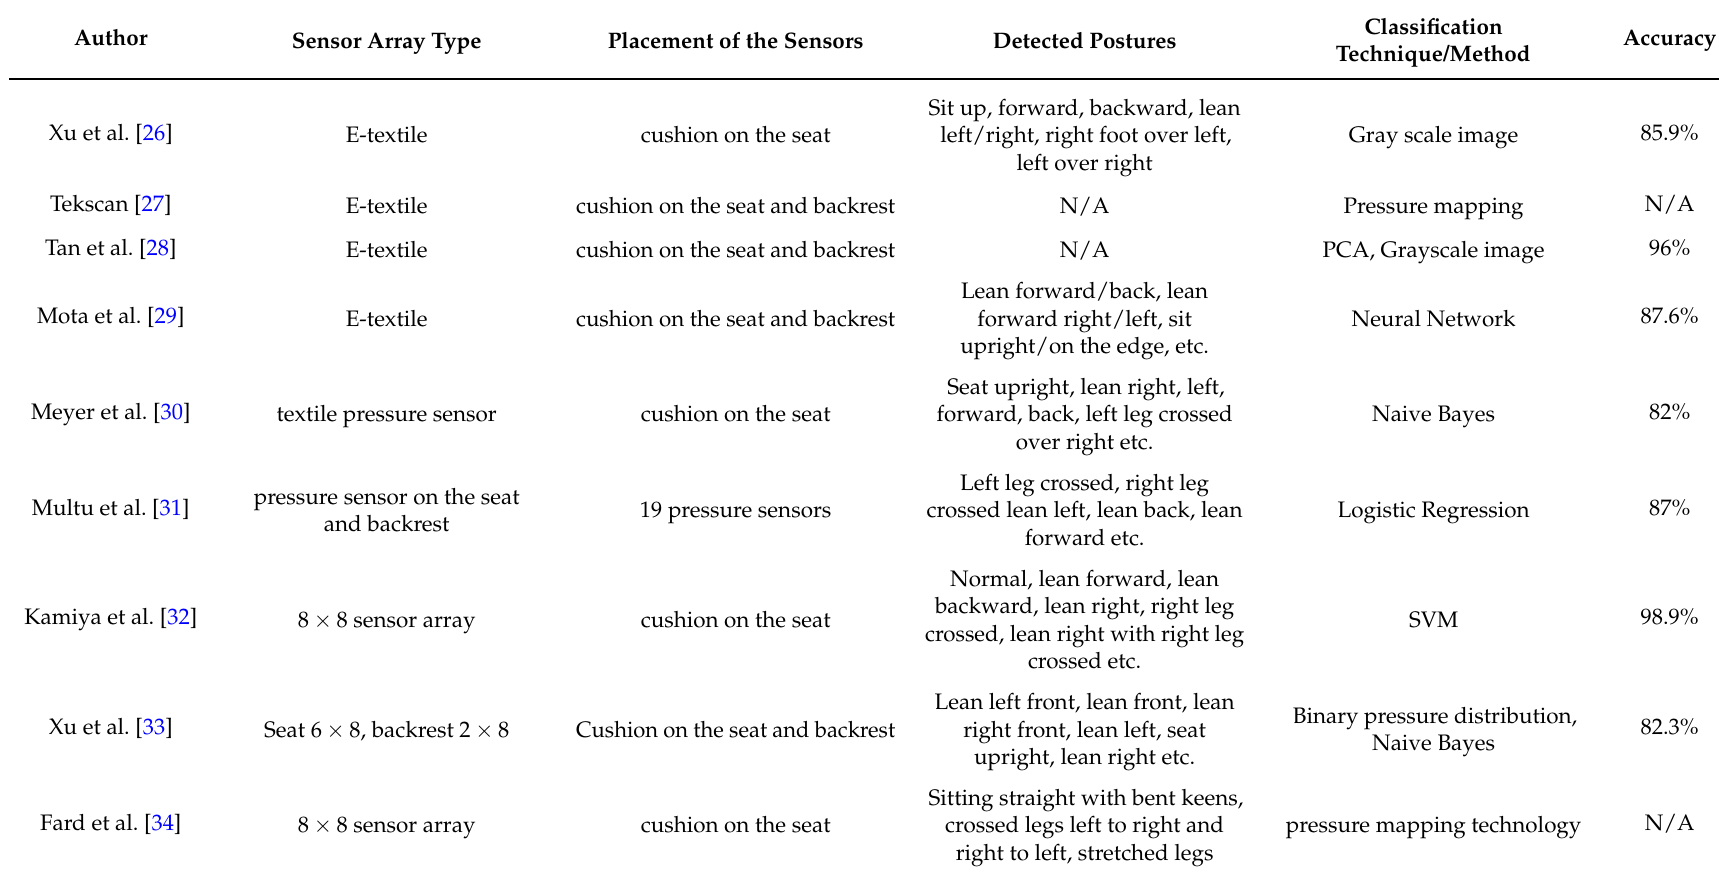
Table 1. State-of-the-art on smart cushions based on pressure sensor